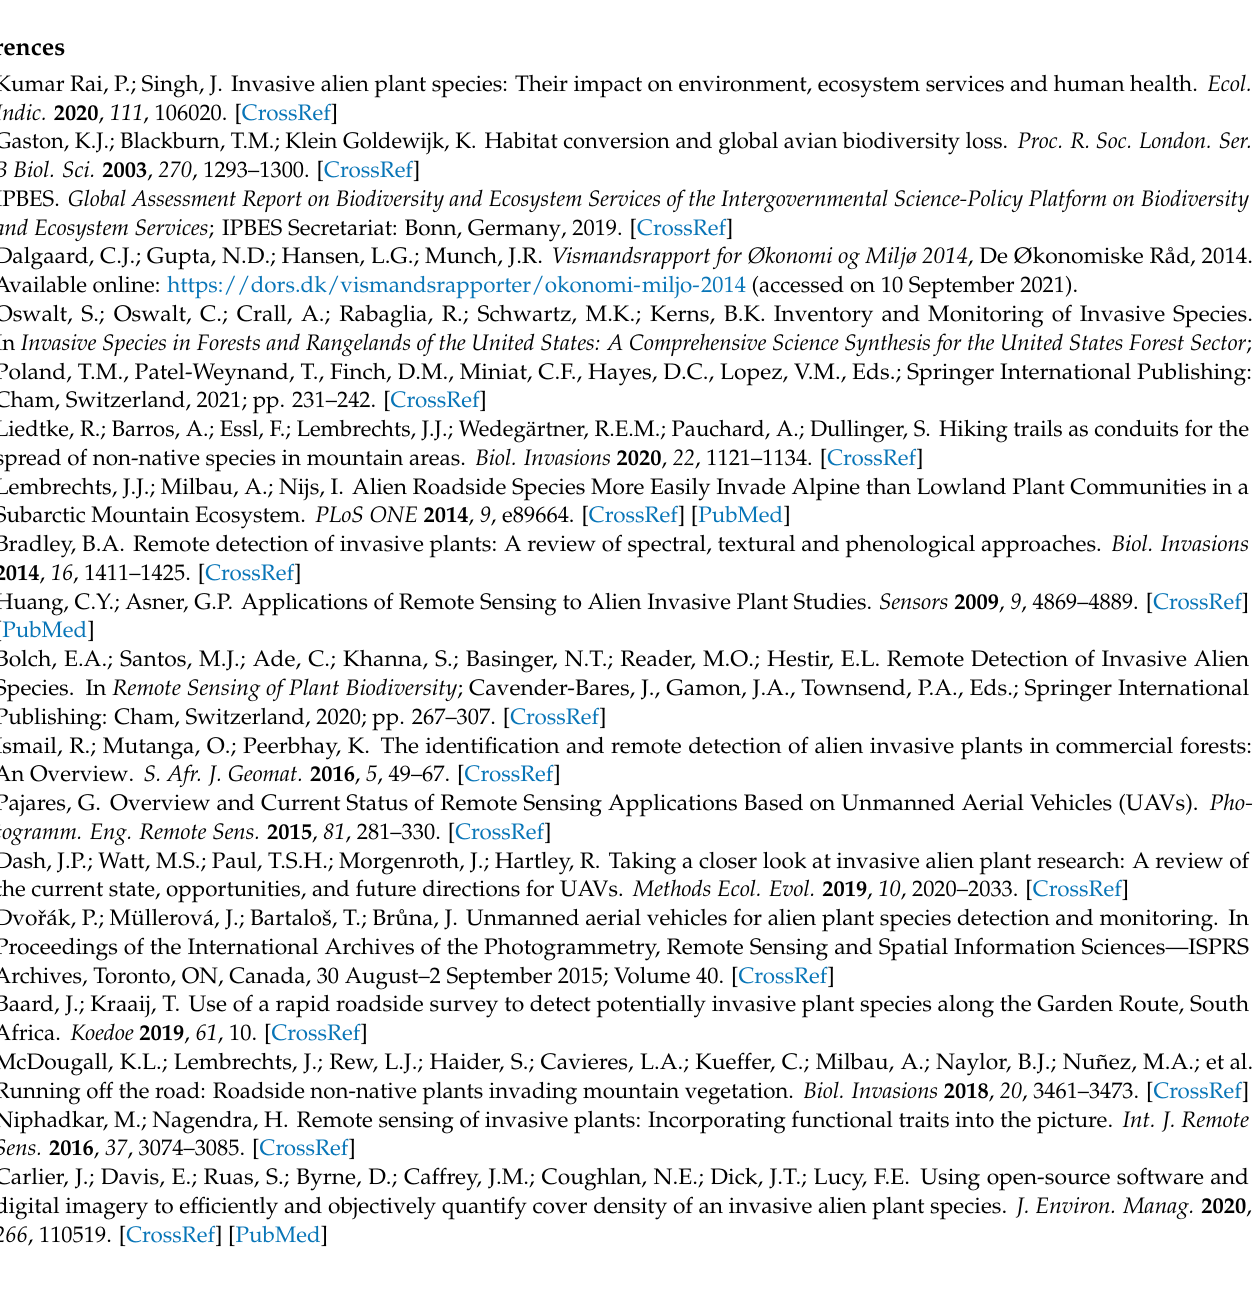
Figure S2: Lupinus polyphyllus . Figure S3: Pastinaca sativa . Figure S4: Reynoutria . Figure S5: Rosa rugosa . Figure S6: Solidago . Figures S7 and S8: Visual and relative comparison of image sizes, Figure S7: Image classification. Figure S8: Object detection. Figures S9 and S10: Map examples, Figure S9: IAPS by date. Figure S10: Detection confidence by